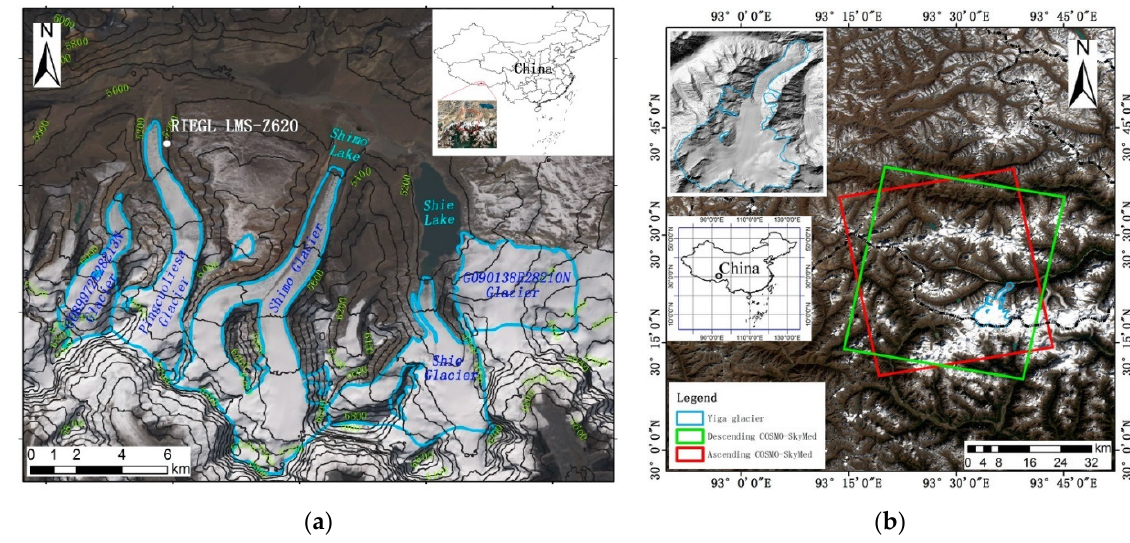
Figure 2. Glaciers studied in the scope of the Dragon 4 project. ( a ) The main results regarding these five glaciers were published in Fan et al. [57]. The solid blue line is the glacial range of The Second Glacier Inventory Dataset of China. ( b ) The location of Yiga Glacier and the coverage of Cosmo–SkyMed data.